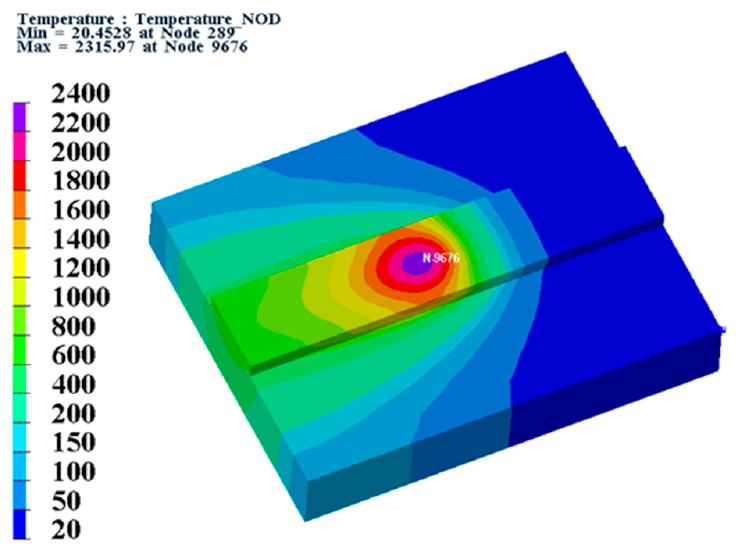
Figure 11. Temperature field cloud diagram at the middle moment of single-pass single-layer surfacing process.